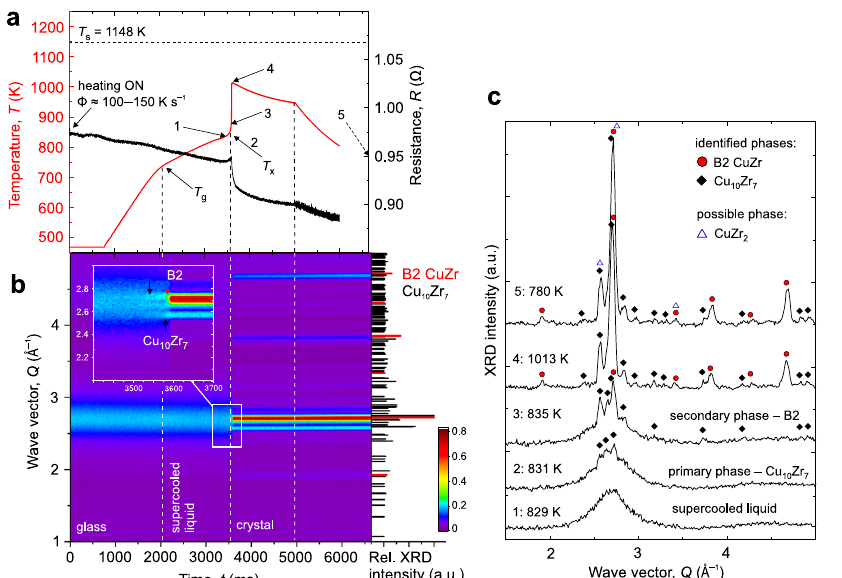
Fig. 1 In situ high-energy X-ray diffraction revealing the crystallization mechanism on fl ash-annealing at a subcritical heating rate of Cu 47.5 Zr 47.5 Al 5.0 ribbon in a vacuum. a Time-dependent temperature (red) and resistance (black) on fl ash-annealing at Φ ≈ 100 – 150 K s − 1 . b The temporal evolution of high-energy X-ray pattern. The inset shows a close-up of the crystallization onset for Cu 10 Zr 7 (black arrows) and B2 CuZr (red arrows) phases. The right- hand part in part b plots the relative X-ray intensities which are normalized to the highest-intensity peak. c Selected individual XRD patterns showing the different stages of crystallization and phase transformations. Full and open symbols label respectively the position of the most pronounced peaks of the identi fi ed and possible phases revealed by Rietveld re fi nement — details can be found in Supplementary Information, Supplementary Fig. 2 (high-energy XRD) and Supplementary Fig. 3 (laboratory XRD). The labeled points correspond to the time of 1: 3505 ms; 2: 3532 ms; 3: 3588 ms; 4: 3610 ms; and 5: